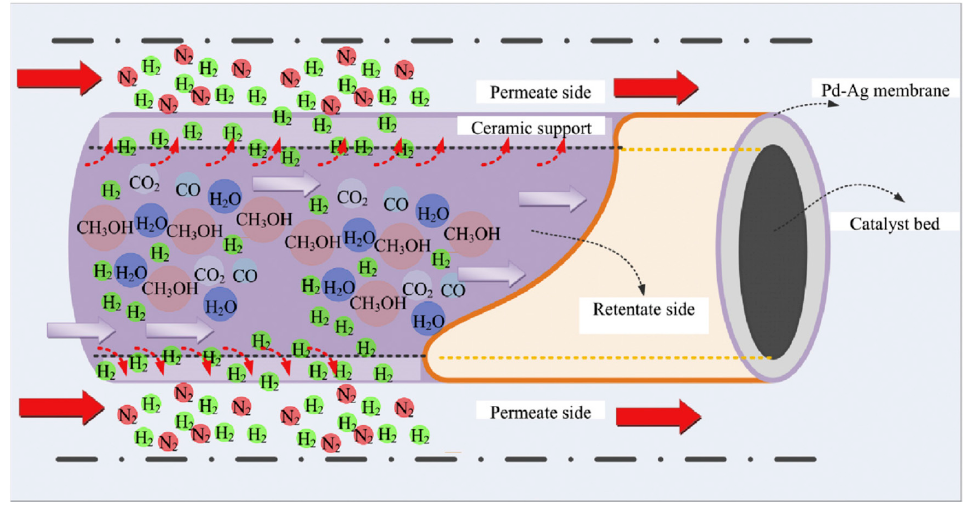
Figure 18. Scheme of the supported Pd-Ag MR. With permission of reprint of Elsevier from Saidi [64].